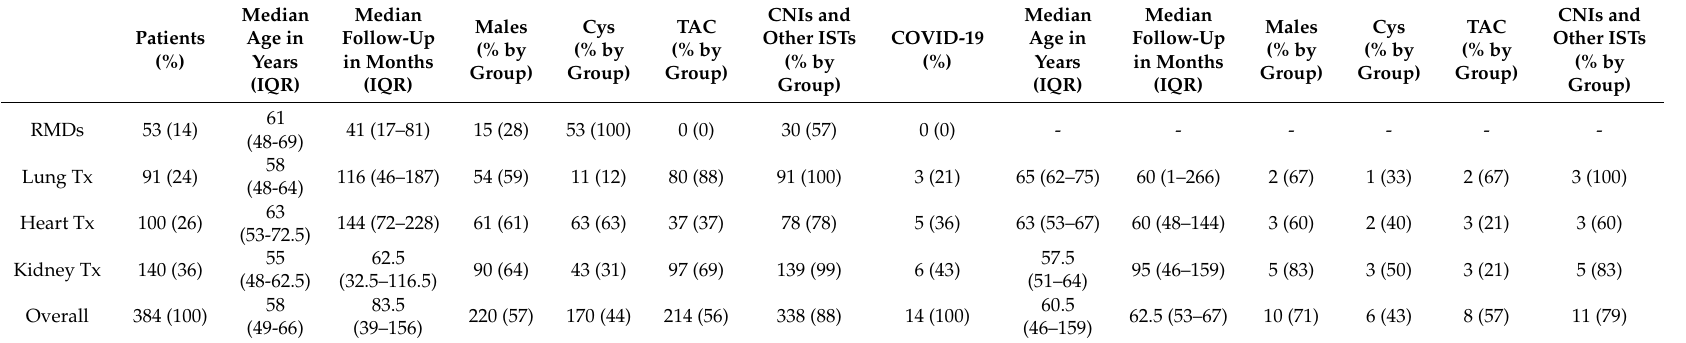
Table 1. General characteristics of patients